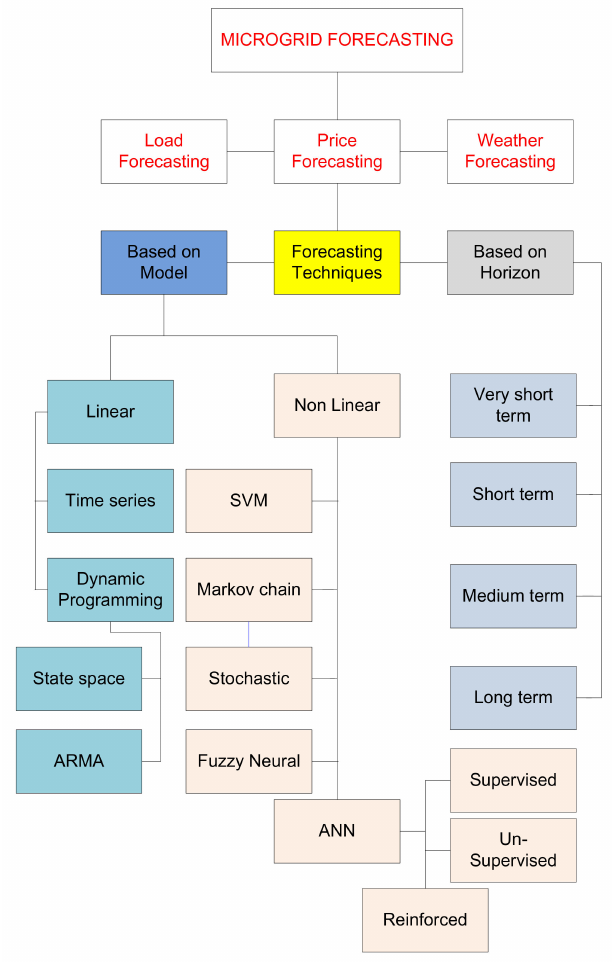
Figure 11. Forecasting techniques in